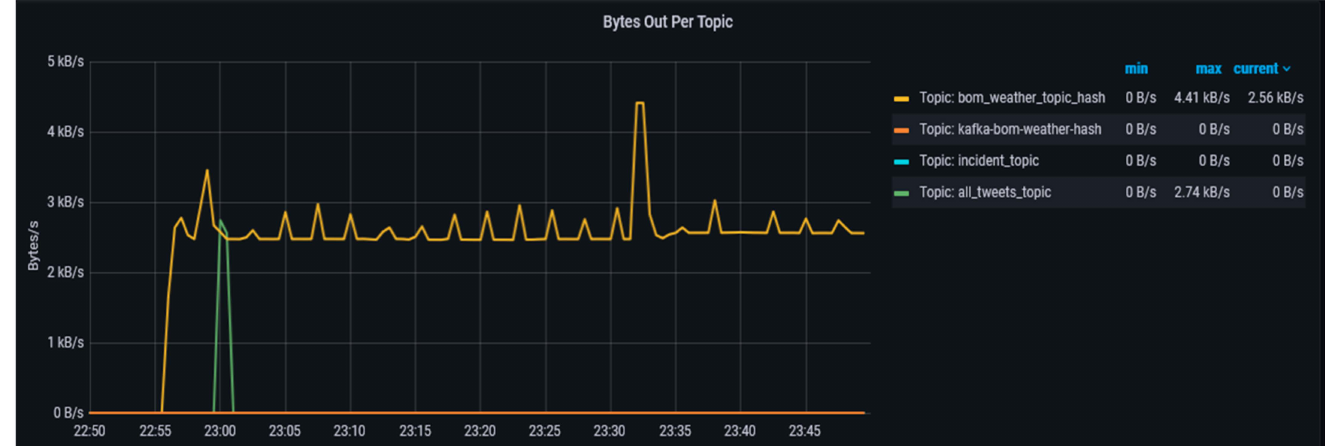
Figure 8. Bytes out from each topic to determine the load being generated by each